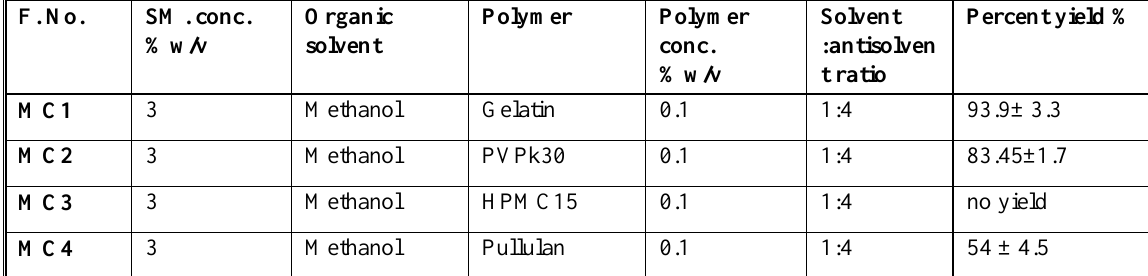
Table (2) Effect of polymer type on SM microcrystals formulas F.